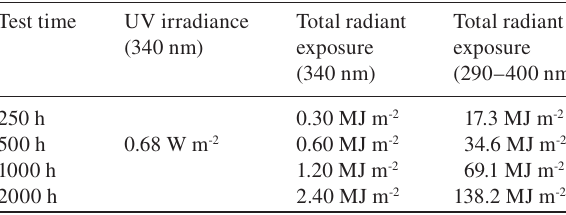
Table 2 Total radiant exposure during the UV step.